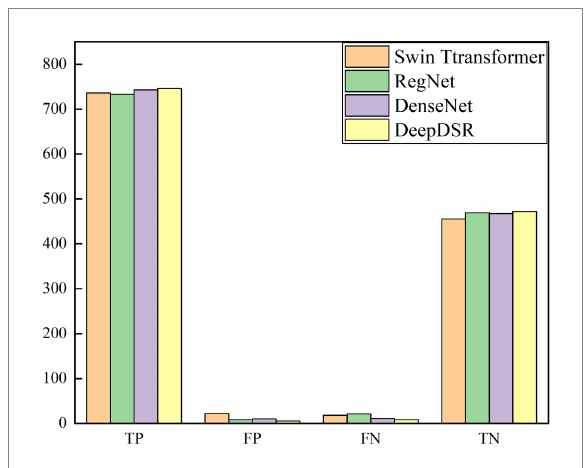
FIGURE 6 Statistical analysis of four methods on 1,231 images.